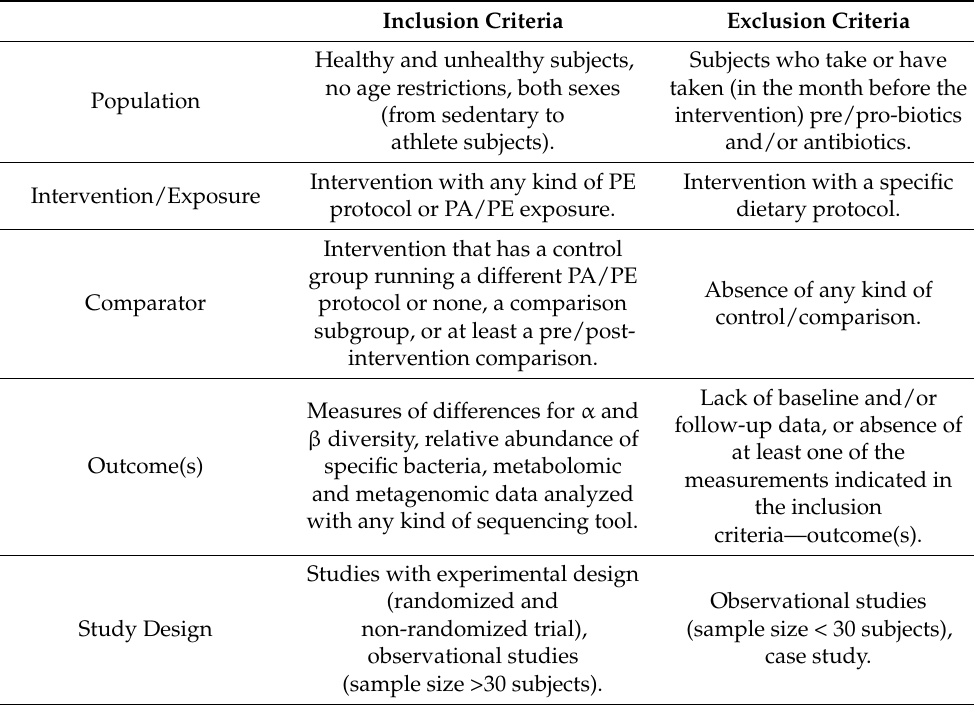
Table 1. Selection criteria used in the systematic